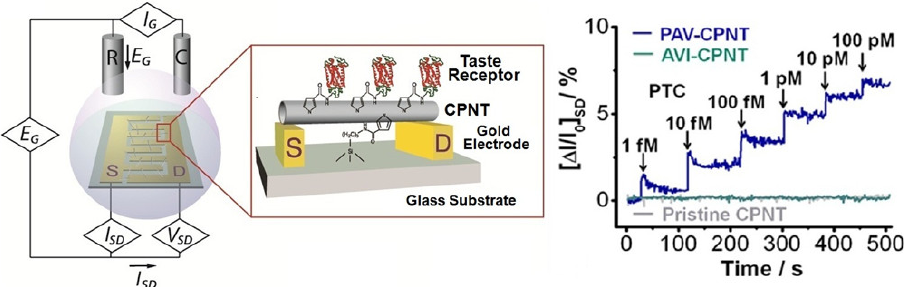
Figure 6. Schematic diagram of a field-effect sensor using taste receptors and its responses to different concentrations of bitter substances. (Reprinted with permission from ref. [59]. Copyright 2013 American Chemical